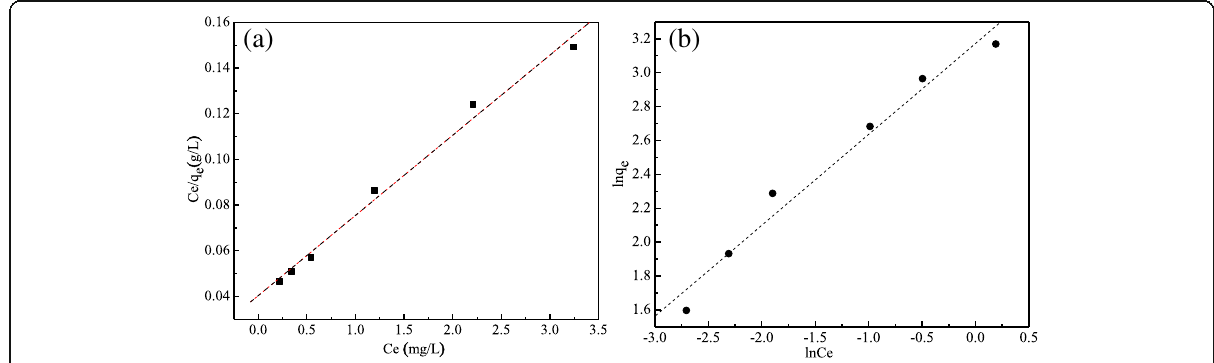
Fig. 5 The adsorption isotherms of MCMs. a Langumir model. b Freundlich